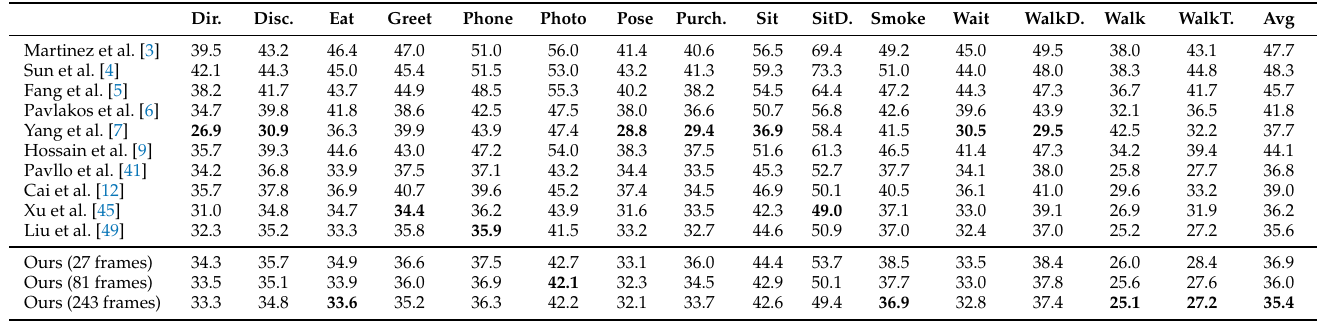
Table 2. Reconstruction error on Human3.6M under protocol 2. Results are in millimeters.